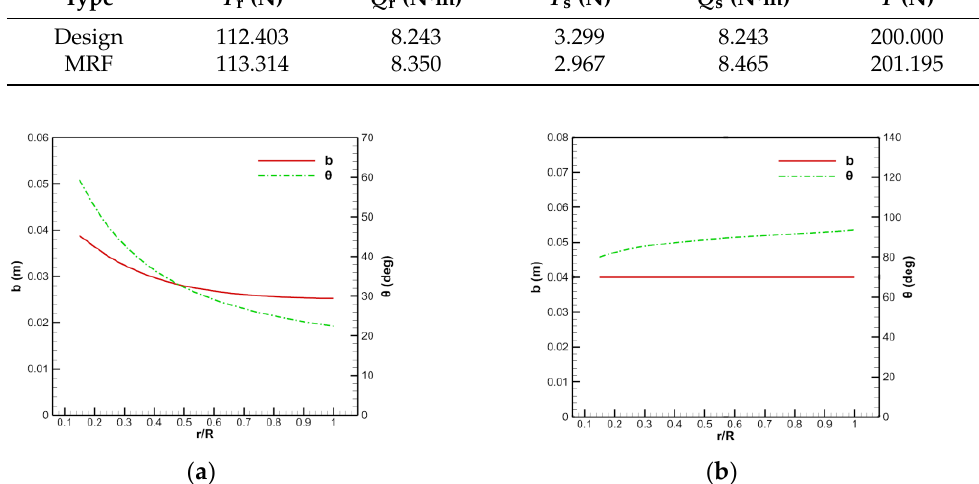
Figure 16. Results of the chord length and torsion angle of the blade of the 400 ducted fan: ( a ) Rotor, ( b ) stator.